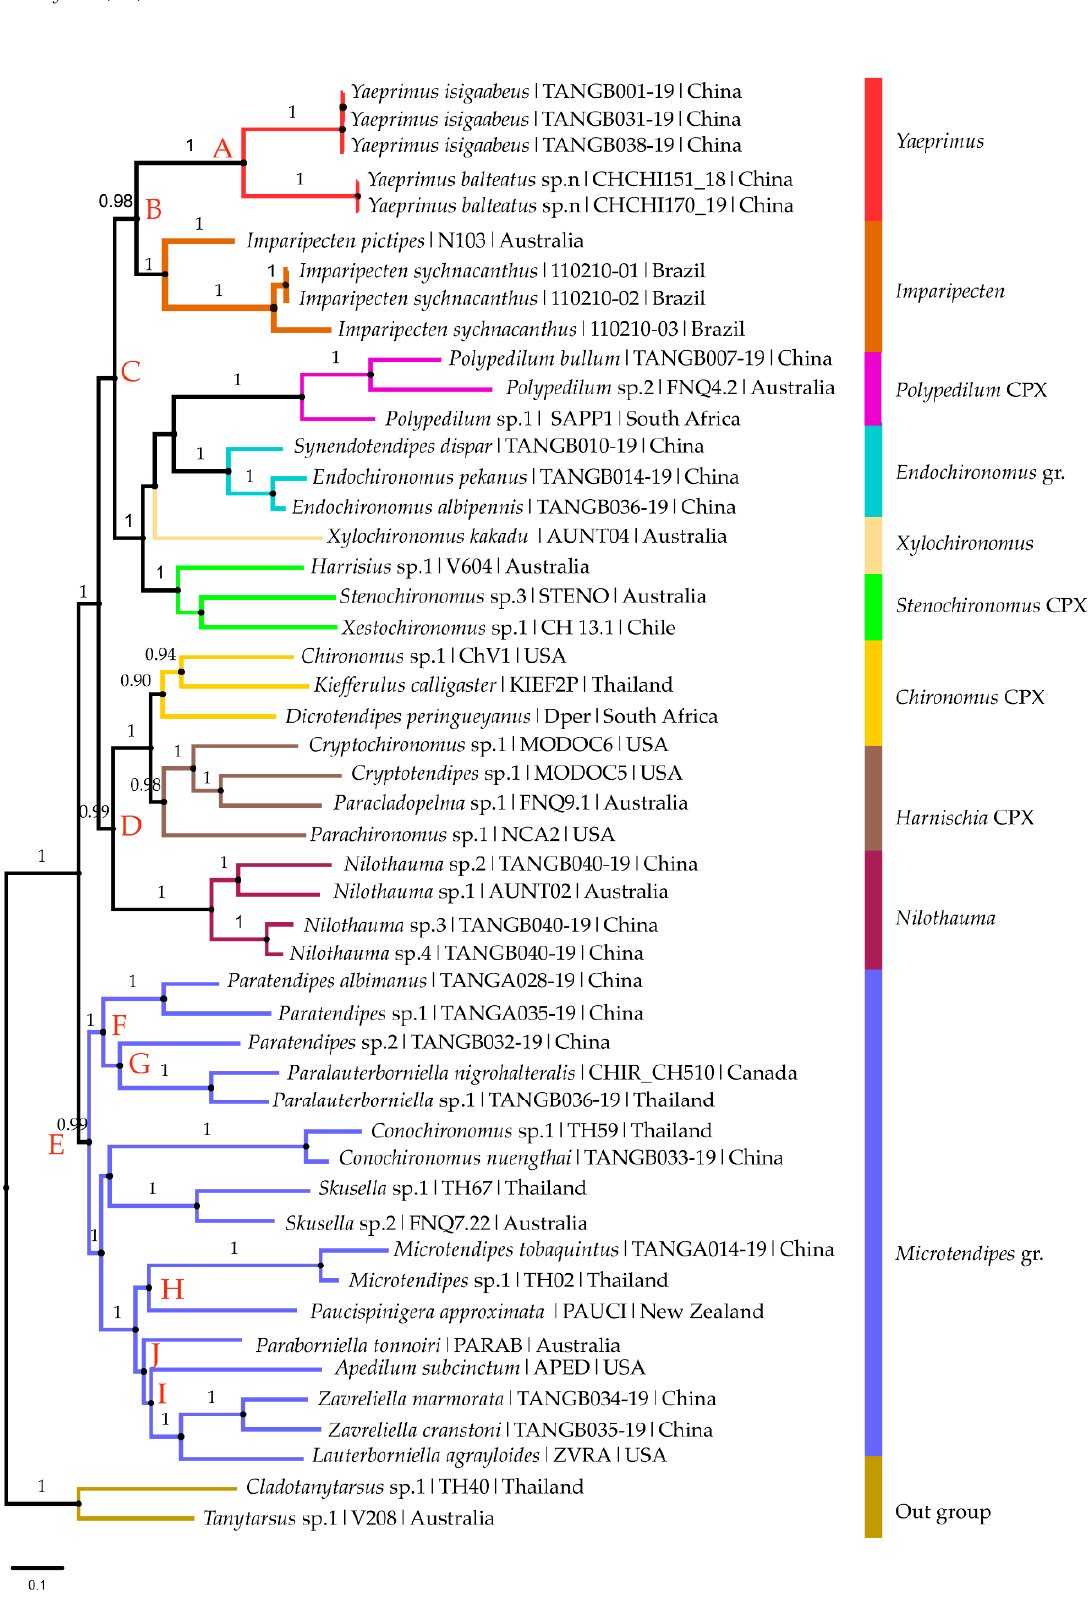
Figure 3. Bayesian inference tree based on concatenated genes ( 18S, 28S CAD1, CAD4, COI–3P ) fragments. Nodes are labeled by posterior possibilities (PP), only PP > 0.90 are shown.